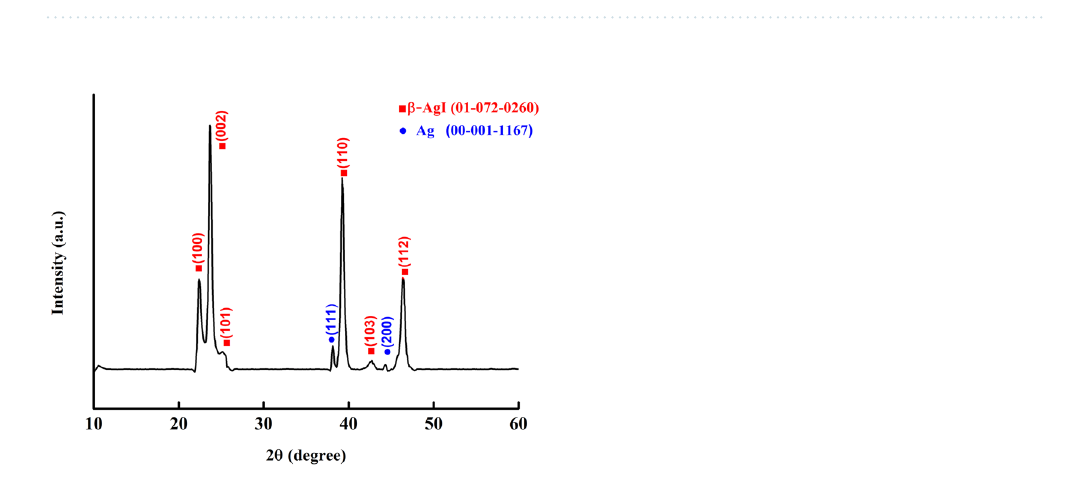
Table 2. Results for absorbance, zeta potential, and particle size distribution.